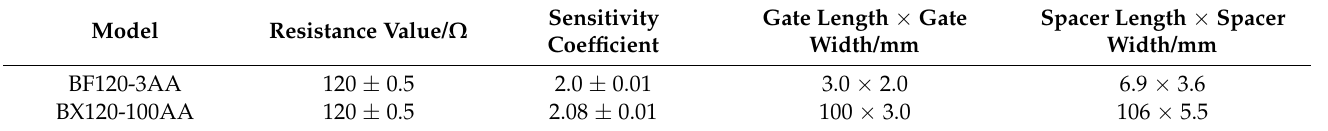
Table 6. Parameters of strain gauge.